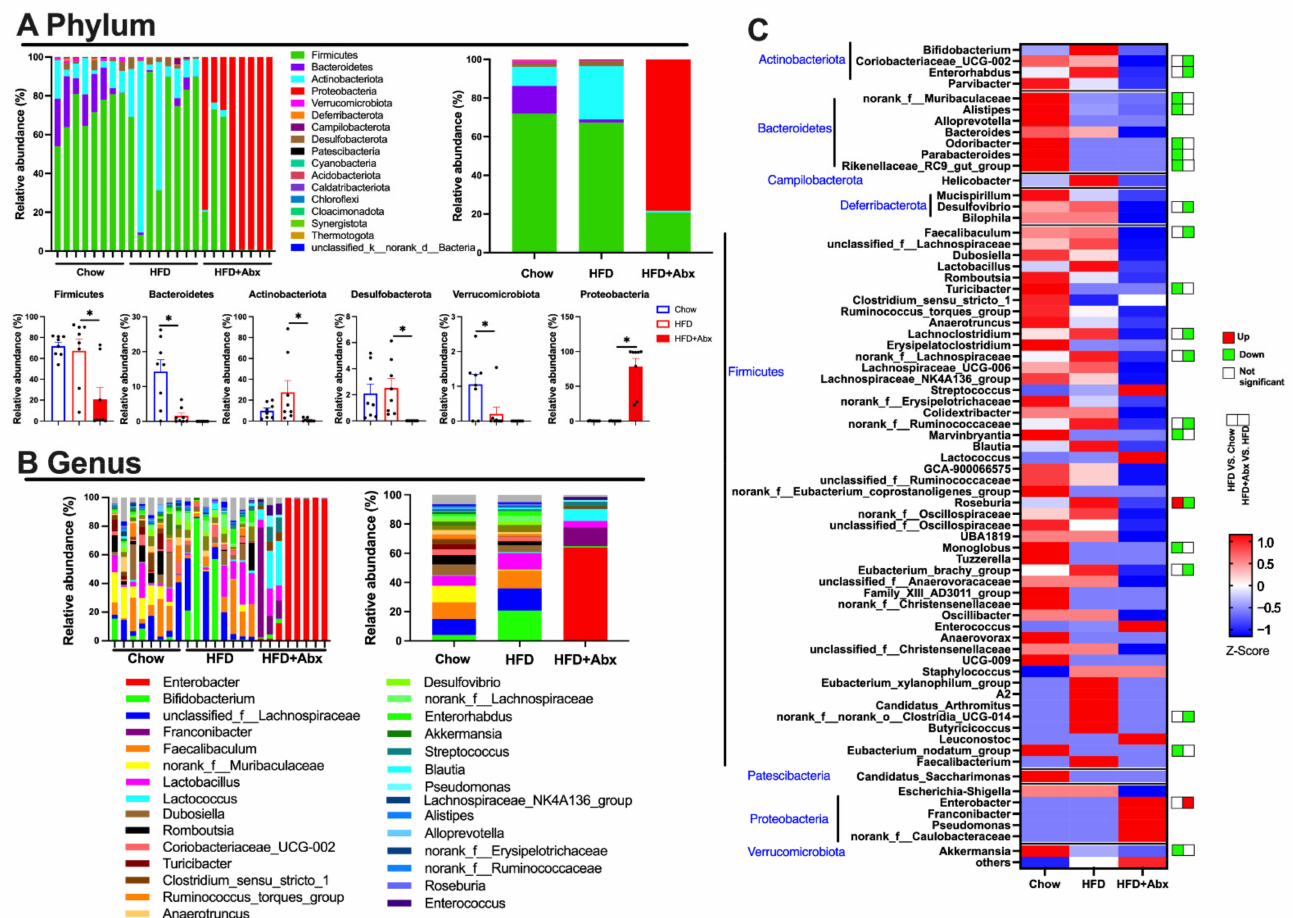
Figure 2. Gut microbiota depletion changed the microbial composition in HFD-fed mice. ( A ) Bacterial taxonomic profiling at the phylum level of fecal microbiota from different groups; ( B ) bacterial taxonomic profiling at the genus level of fecal microbiota from different groups; ( C ) heatmap of the bacterial taxonomic profiling at the genus level of fecal microbiota from different groups. Data were expressed as the mean ± SEM. * p <